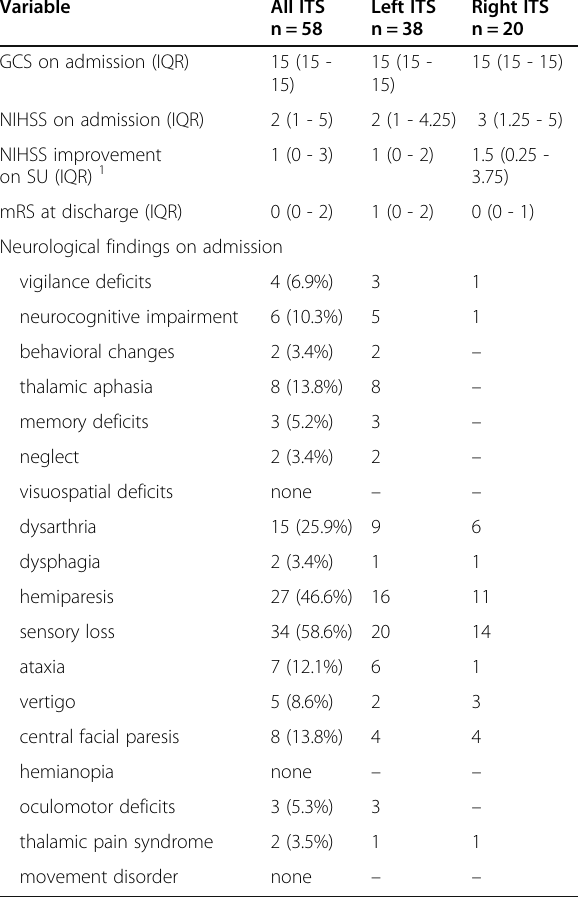
Table 3 Clinical